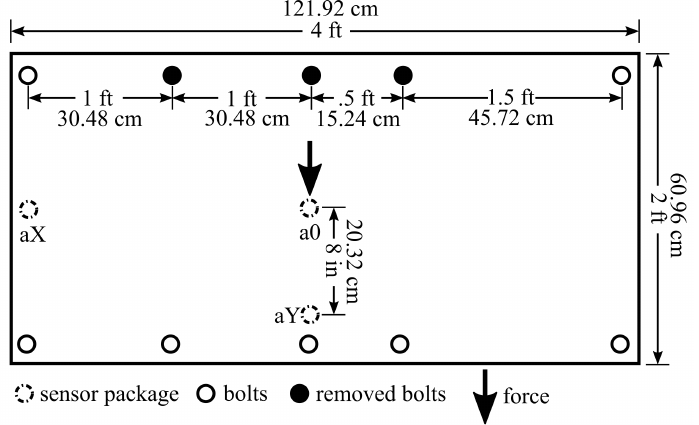
Figure 7. Schematic of the steel plate structure used in the experiments featuring the sensor package placement and the relative location of the supporting bolts used to simulate